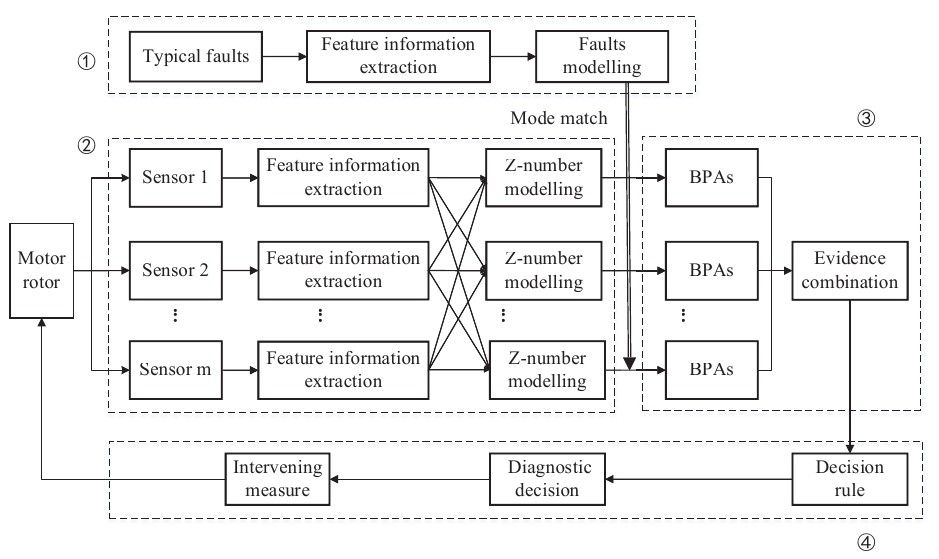
Figure 2. The procedure of fault diagnosis with the proposed